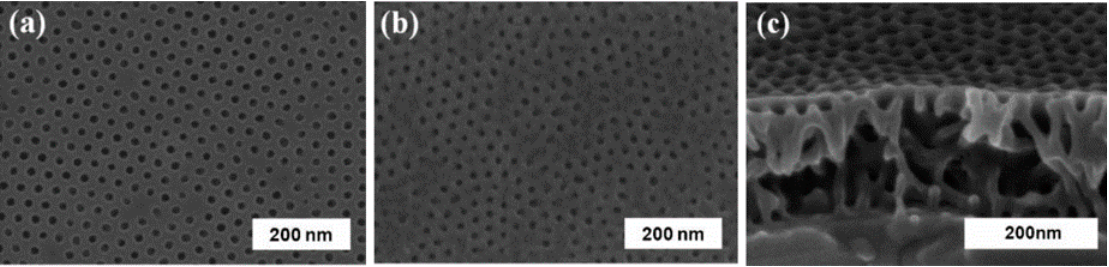
Figure 10. SEM images of nanoporous membrane. ( a ) top surface; ( b ) bottom surface; ( c ) cross-sectional view. Figures are reprinted with permission from Ref. [104]. Copyright Wiley-VCH, 2008.